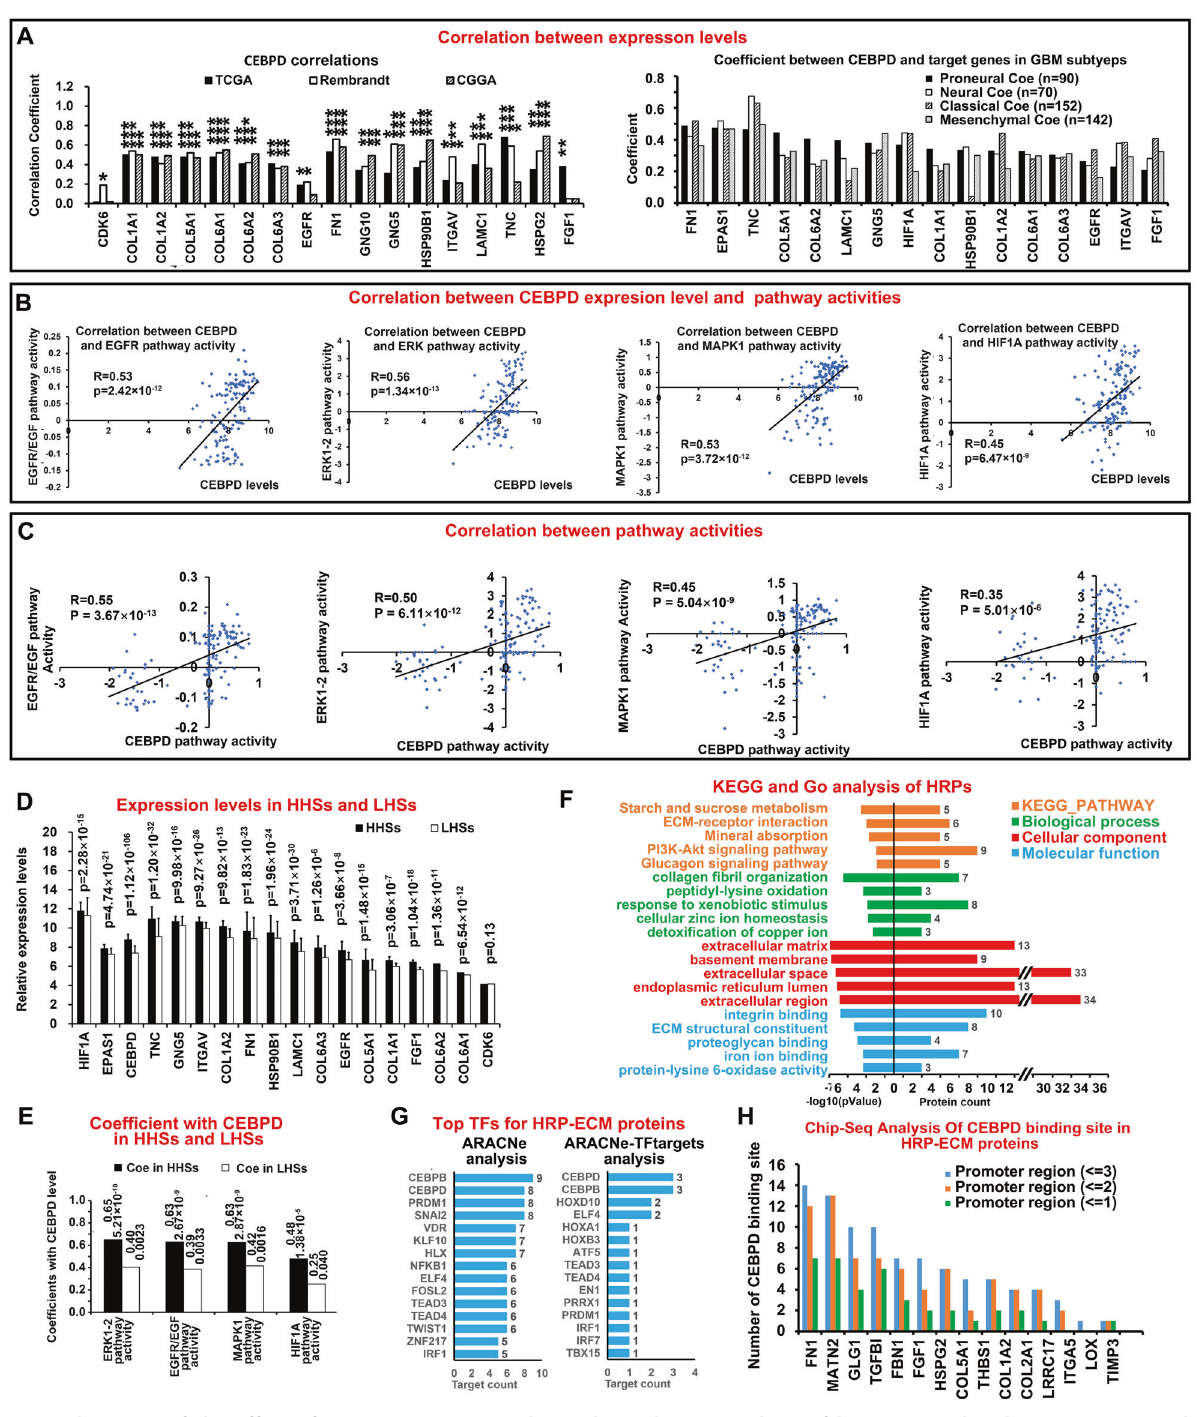
Fig. 7 Corroboration of the effect of CEBPD in GBM samples and enrichment analysis of hypoxia-regulated proteins. A Correlations between expression levels of CEBPD and genes in EGFR/PI3K pathways (left image) in different databases (TCGA, Rembrandt, and CGGA). * P < 0.05, **(vertical) P < 10 − 5 , ***(vertical) P < 10 − 10 . In addition, correlations of CEBPD and these genes in each GBM subtype (Proneural, Neural, Classical, and Mesenchymal) were further performed in the TCGA database to test the impact of subtype on the correlations. B Correlations between CEBPD expression level and pathway activities of EGFR/PI3K and HIF1A. C Correlations between pathway activities of CEBPD and EGFR/PI3K related pathways, HIF1A pathways. D Expression levels of HIFs (HIF1A and EPAS1), CEBPD and genes in EGFR/PI3K pathways in high hypoxic samples (HHSs) and low hypoxic samples (LHSs) in the TCGA database. E Coef fi cients between CEBPD level and EGFR, HIF1A pathway activities in HHSs and LHSs. Digital labels for each bar indicate the coef fi cients (R, left label) and p values (right label). F KEGG pathway analysis and Gene Ontology (GO) analysis of HRPs in U87 cells. Analyzed GO Categories include Biological process (BP), Cellular component (CM), and Molecular function (MF). The colored bars represent the − log10( p Value) (left panel) and count of protein (right panel) for each enriched items. G Top TF analysis of ECM proteins belong to the HRPs (HRP-ECM), as described in Fig. 1. H Chip-seq analysis of CEBPD binding sites in HRP-ECM proteins. Bars represented number of CEBPD binding sites identi fi ed by Chip-seq in the promoters of the indicated